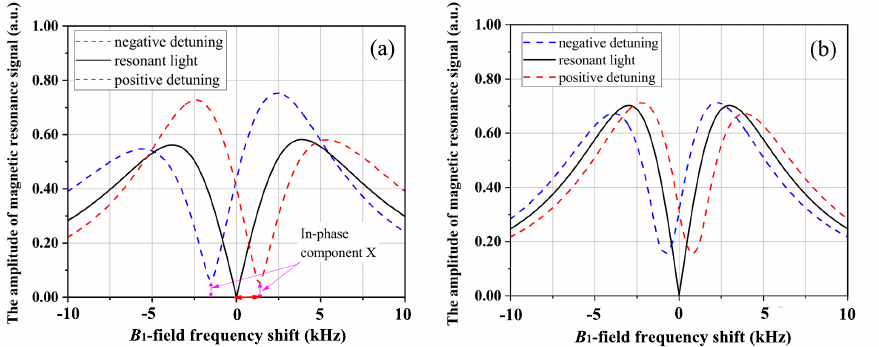
Figure 2. ( a ) Experimental results of the amplitude of demodulated magnetic resonance signal with different laser detunings. The positive detuning is about 800 MHz and the negative detuning is about − 800 MHz. The amplitude of in-phase component X does not vanish when laser is detuned and the Larmor frequency is obtained by the quadrature component Y locked at zero. ( b ) The theoretically simulated results of the amplitude of demodulated magnetic resonance signal with and without laser detuning, after considering the spatially inhomogeneous light